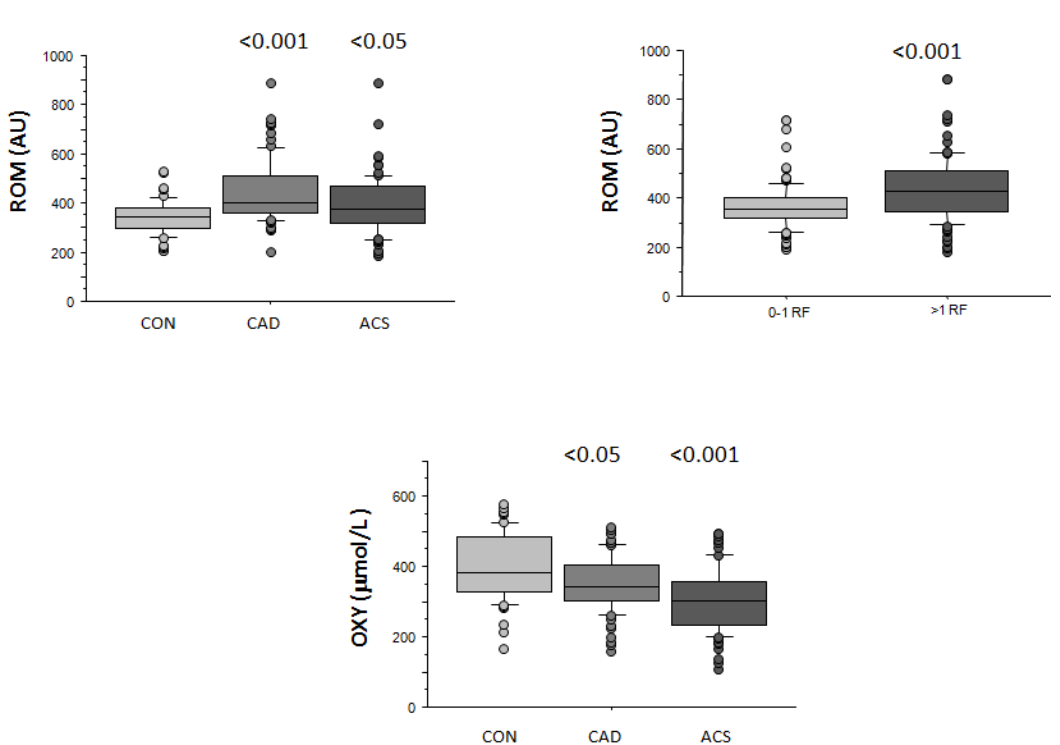
Figure 2. Reactive oxygen metabolites (ROM) levels in the three groups (control (CON), coronary artery disease (CAD), and acute coronary syndromes (ACS)), and according to number of risk factors (determinants included are type 2 diabetes (T2D), hypercholesterolemia, hypertension, smoking history), and antioxidant capacity (OXY) levels in CON, CAD, and ACS. Results are expressed as median and interquartile range. p < 0.05, p < 0.001 versus baseline.